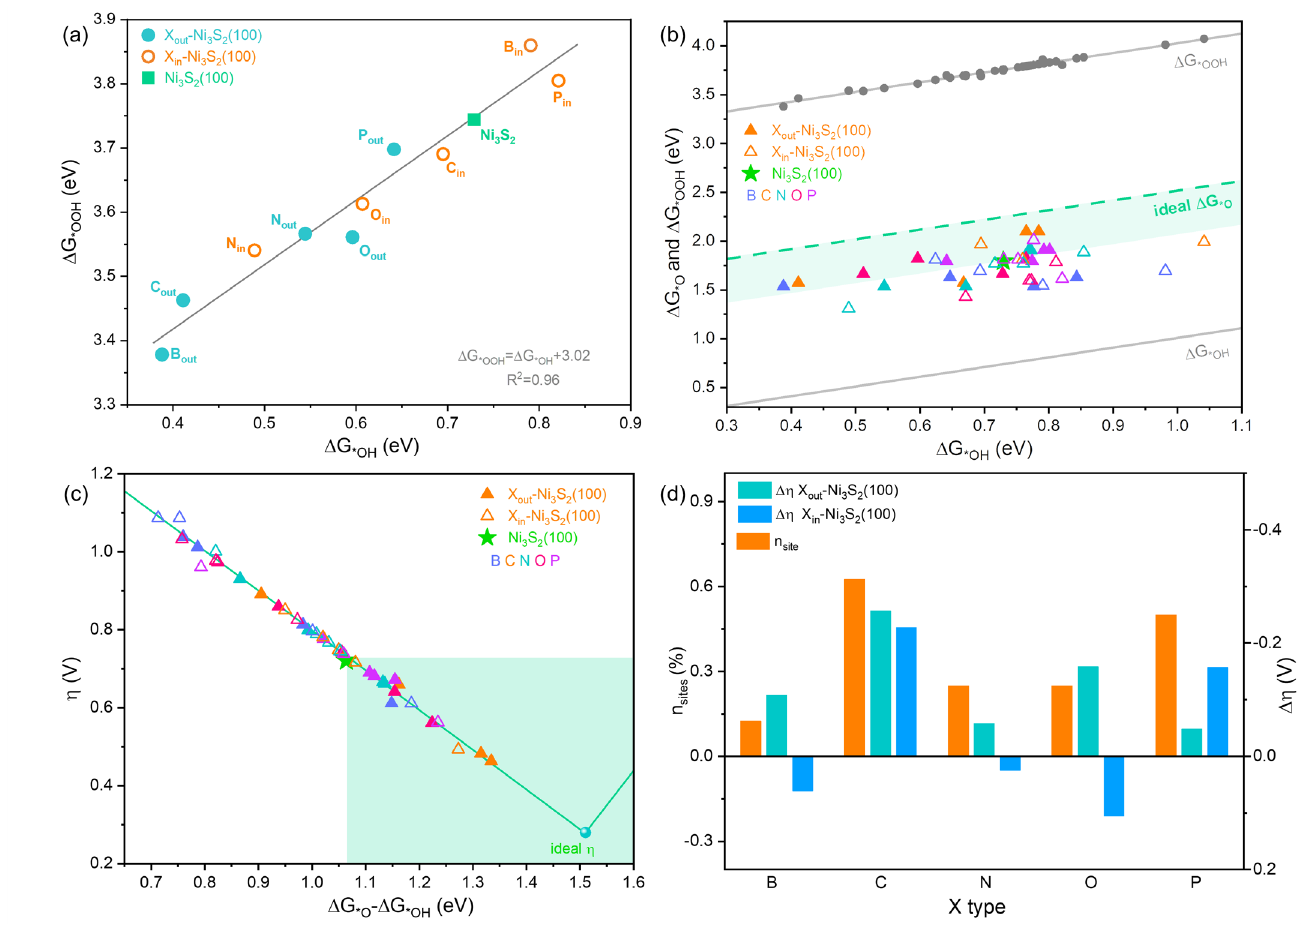
Figure 3. ( a ) The scale relation between ∆ G ∗ OH and ∆ G ∗ OOH . ( b ) The correlation between ∆ G ∗ O (or ∆ G ∗ OOH ) and ∗ OH , and ( c ) the η vs. value of ∗ O − ∗ OH on different X-Ni 3 S 2 (100) surfaces (the highlighted area in ( b ) and ( c ) denote the relative optimum ∆ G ∗ O and small η values of X-Ni3S2(100), respectively). ( d ) The improved active site proportion (nsite) on X-Ni3S2(100) and the difference between minimum η of each surface and η of Ni3S2 (100).